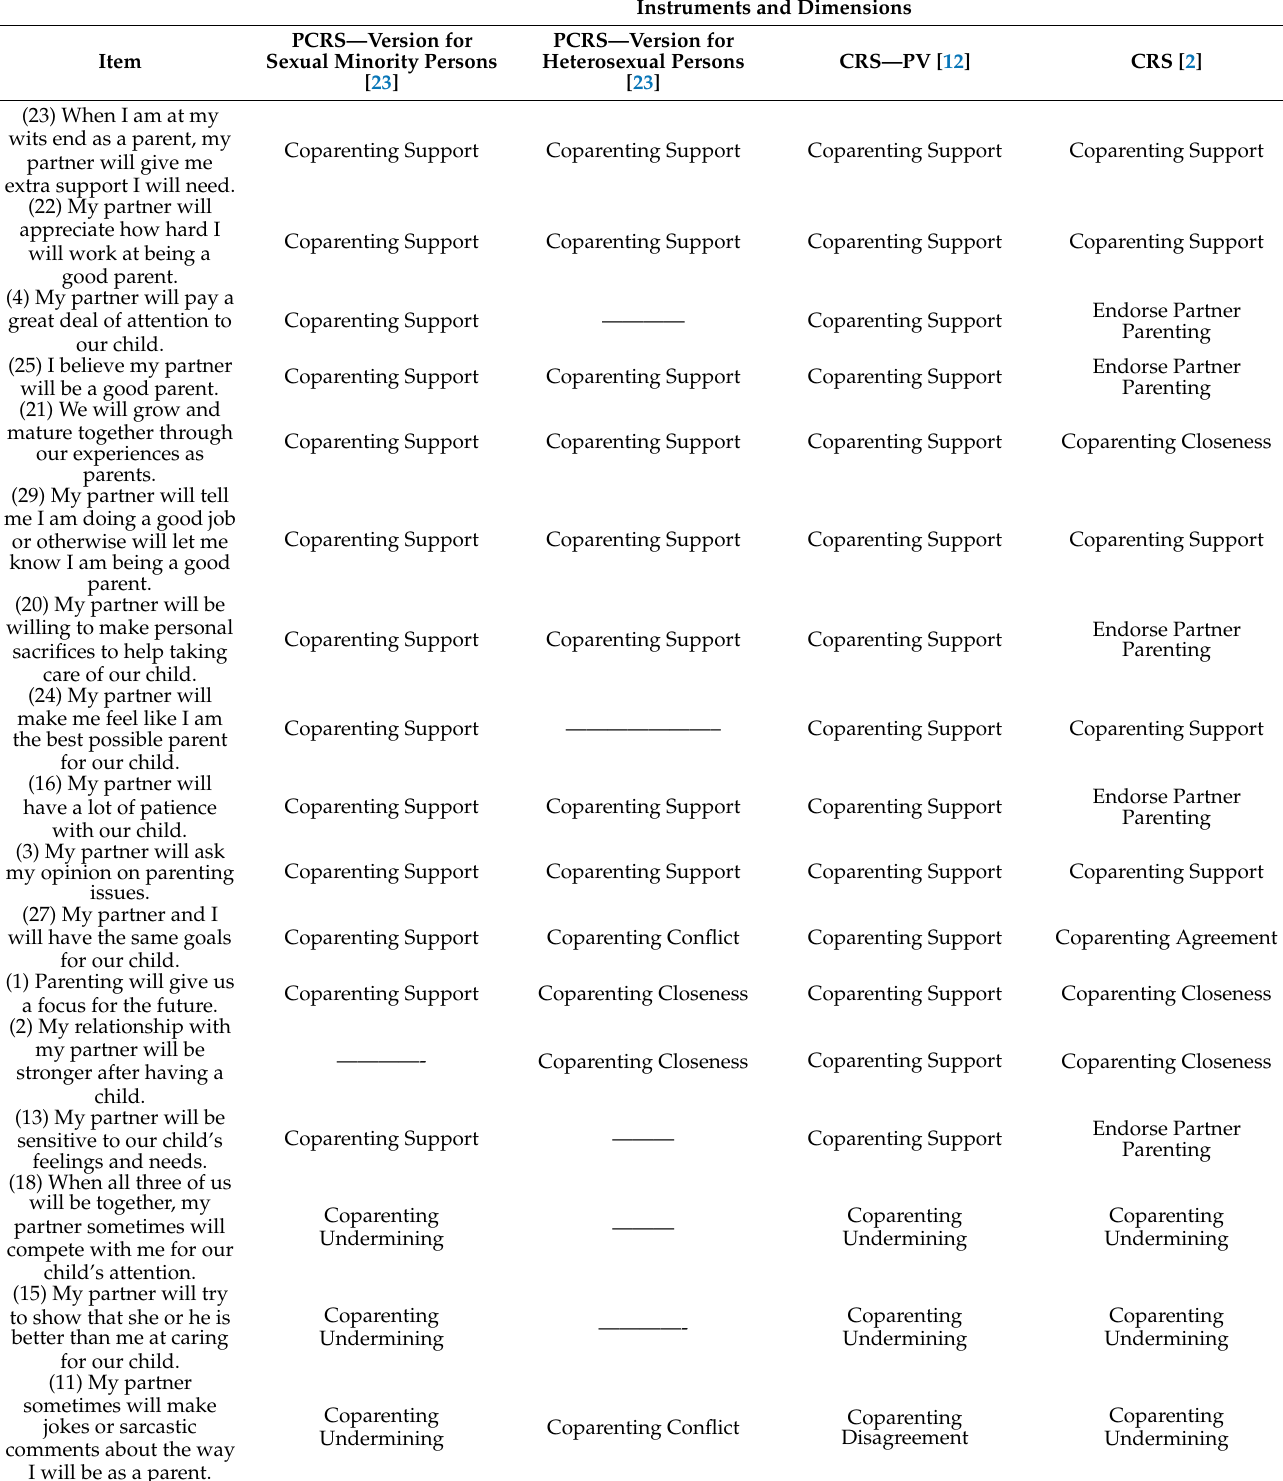
Table A1. Differences and similarities between The Coparenting Relationship Scale (CRS) [2], The Co- parenting Relationship Scale—Father’s Prenatal Version (CRS—PV) [12], The Prospective Coparenting Relationship Scale (PCRS)